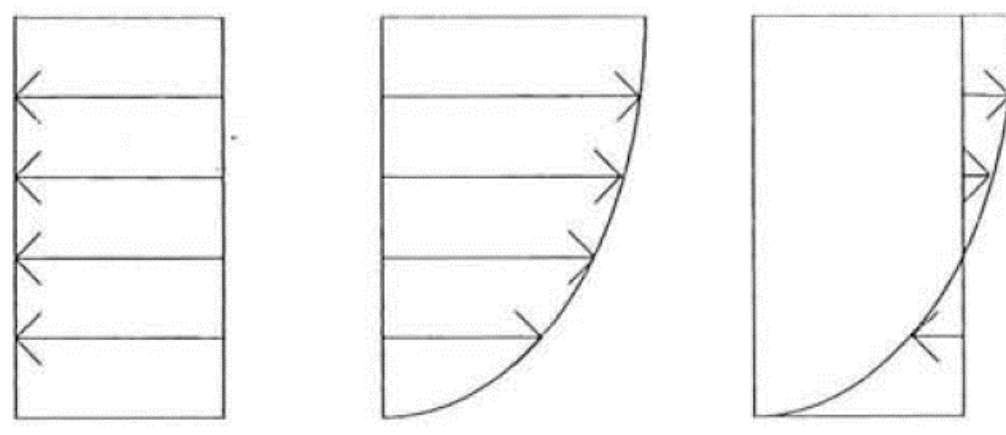
Figure 2. Centripetal and centrifugal acceleration (Jongbloed, 1996) [28]. At the exit of the bend, there is a positive pressure gradient near the interior wall and a negative one close to the exterior wall. The free surface slope decreases towards the bend exit until it may gradually become zero at the end of the bend.